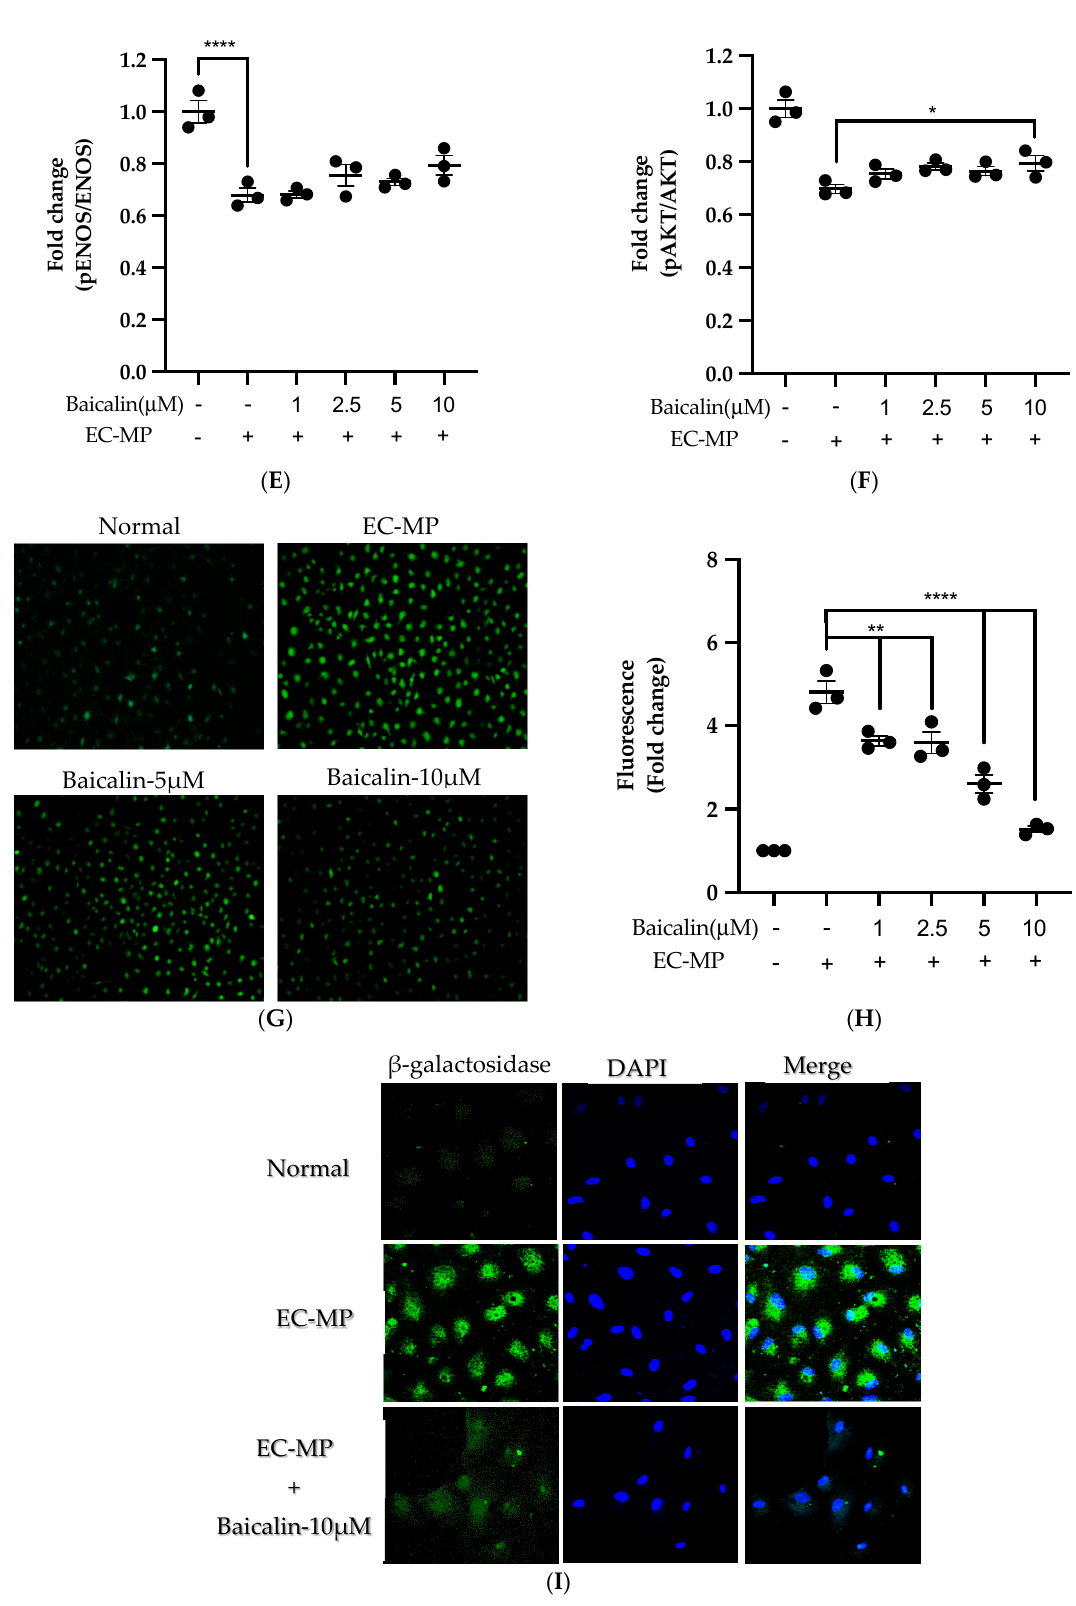
Figure 4. Effect of baicalin on endothelial dysfunction marker. ( A ) EC was incubated with EC-MP and various doses of baicalin for 24 h, followed by MTT solution for 4 h. The absorbance of purple formazan was taken at 540 nm. ( B ) EC treated with or without EC-MP, and a various dose of baicalin was incubated with Annexin V-FITC followed by propodium iodide. Analysis of EC apoptosis was